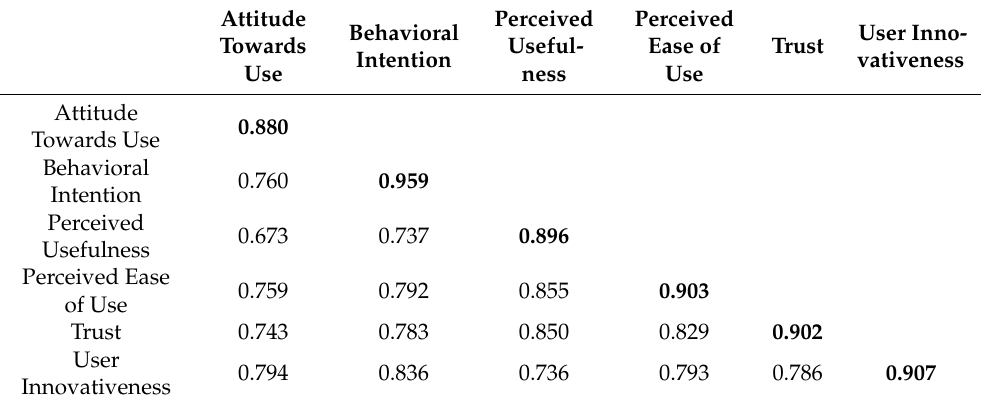
Table 3. Discriminant